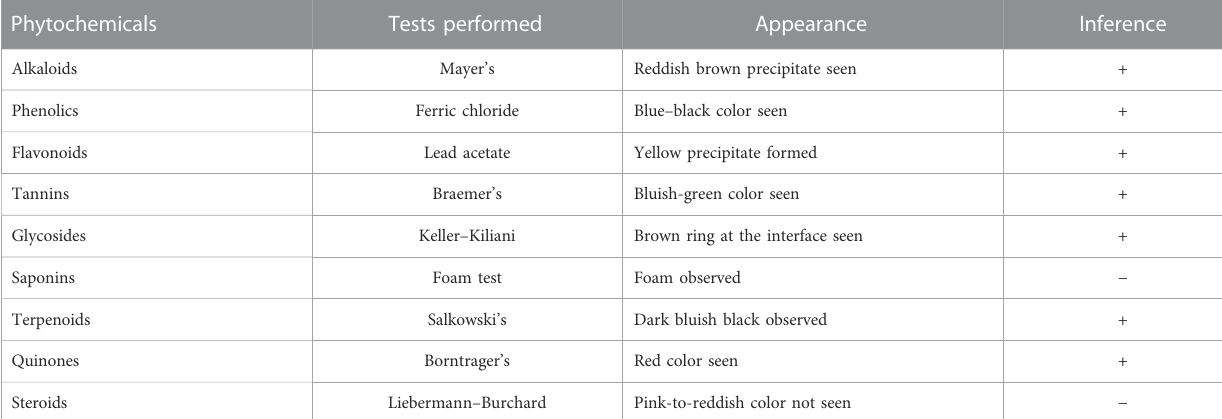
TABLE 1 Preliminary qualitative phytochemical analysis of the AAHY extract.